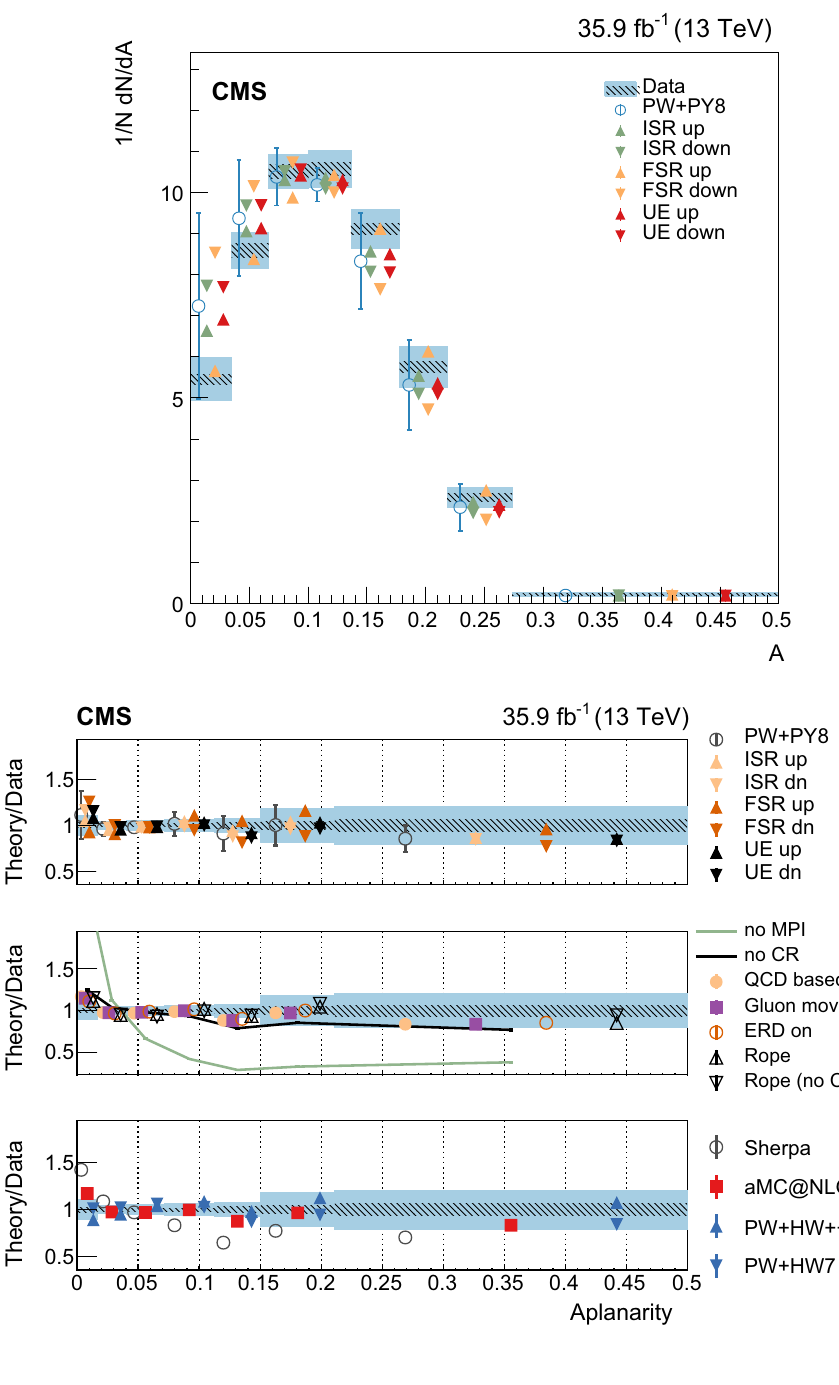
Fig. 11 Normalized differential cross section as function of the aplanarity variable, compared to the predictions of different models. The conventions of Fig. 4 are